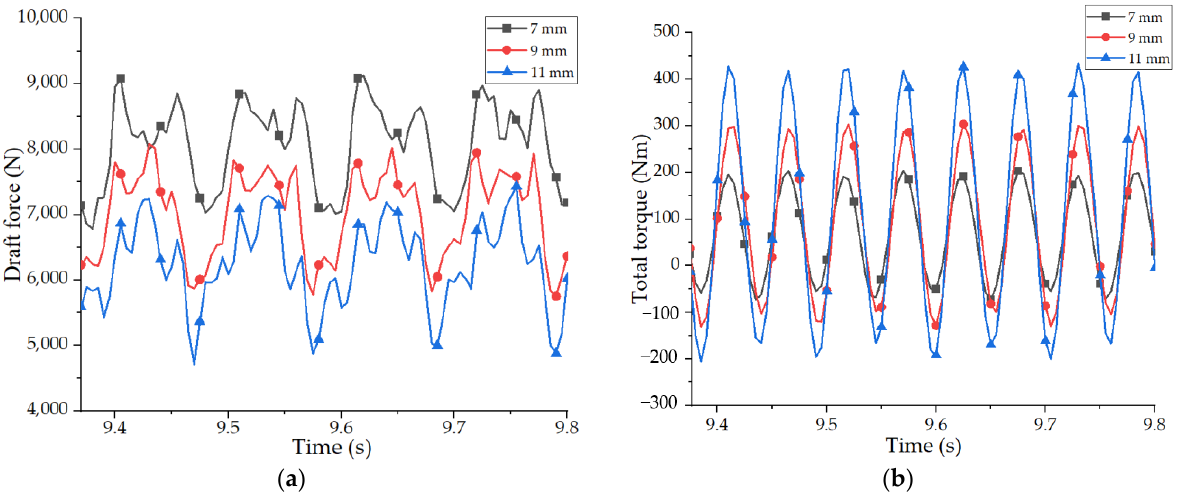
Figure 9. Effect of amplitude on harvester performance: ( a ) Draft force; ( b ) Total torque.